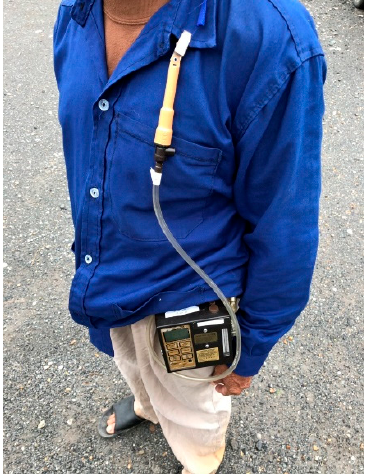
Figure 2. Absorbent tube sampling application.